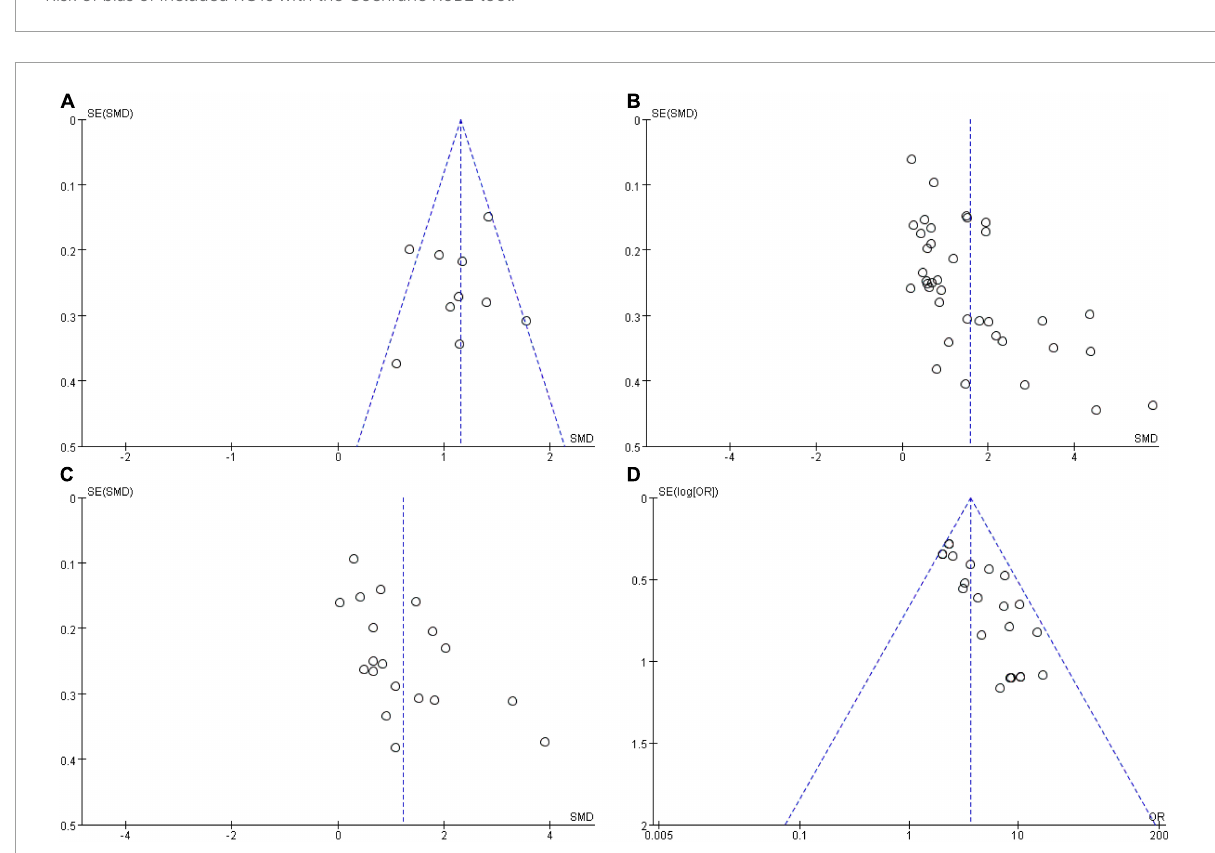
FIGURE3 Funnel plots for publication bias. (A) Publication bias of skill scores; (B) publication bias of knowledge examination scores; (C) publication bias of comprehensive ability scores; (D) publication bias of teaching effect satisfactory. OR, odds ratio; SMD, standardized mean difference.